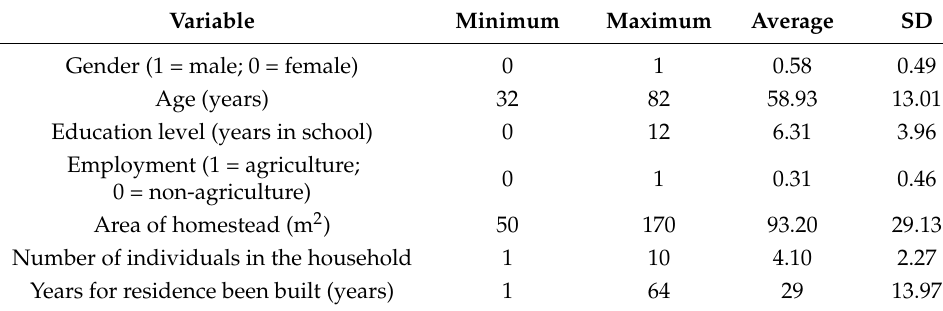
Table 2. Summary statistics of variables used in